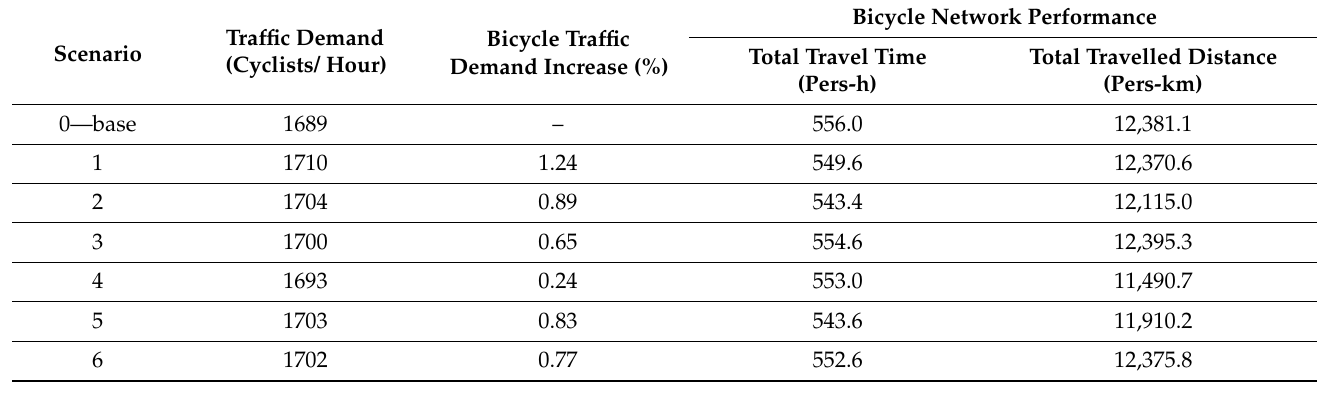
Table 1. Results of simulations for different scenarios of bicycle network development–afternoon peak hour.